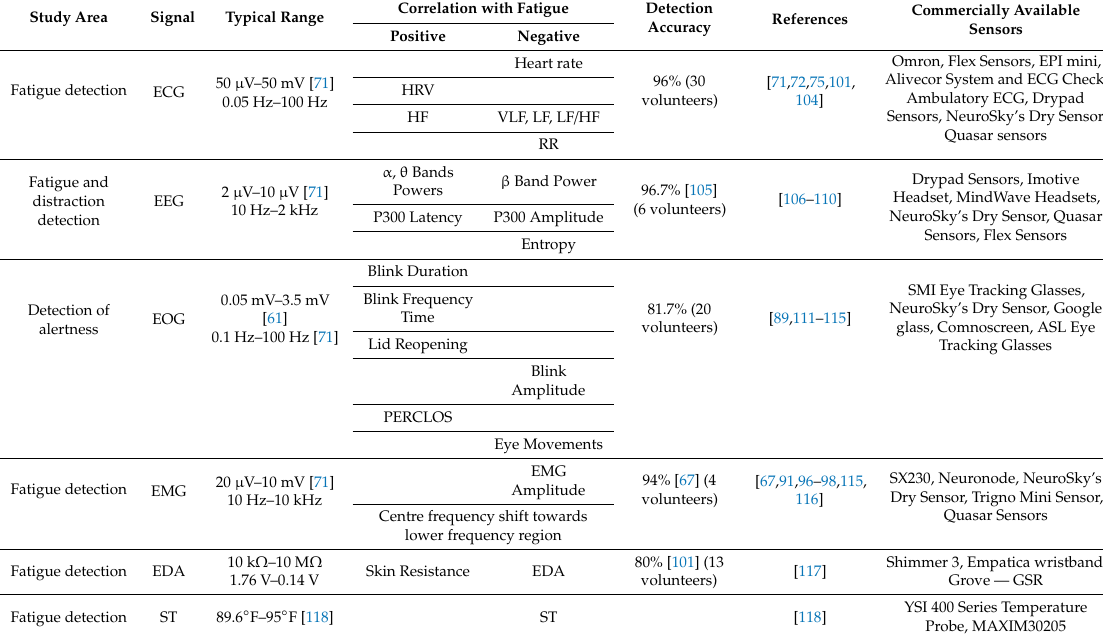
Table 1. A summary of studies related to the driver’s attention monitoring based on biological and physiological